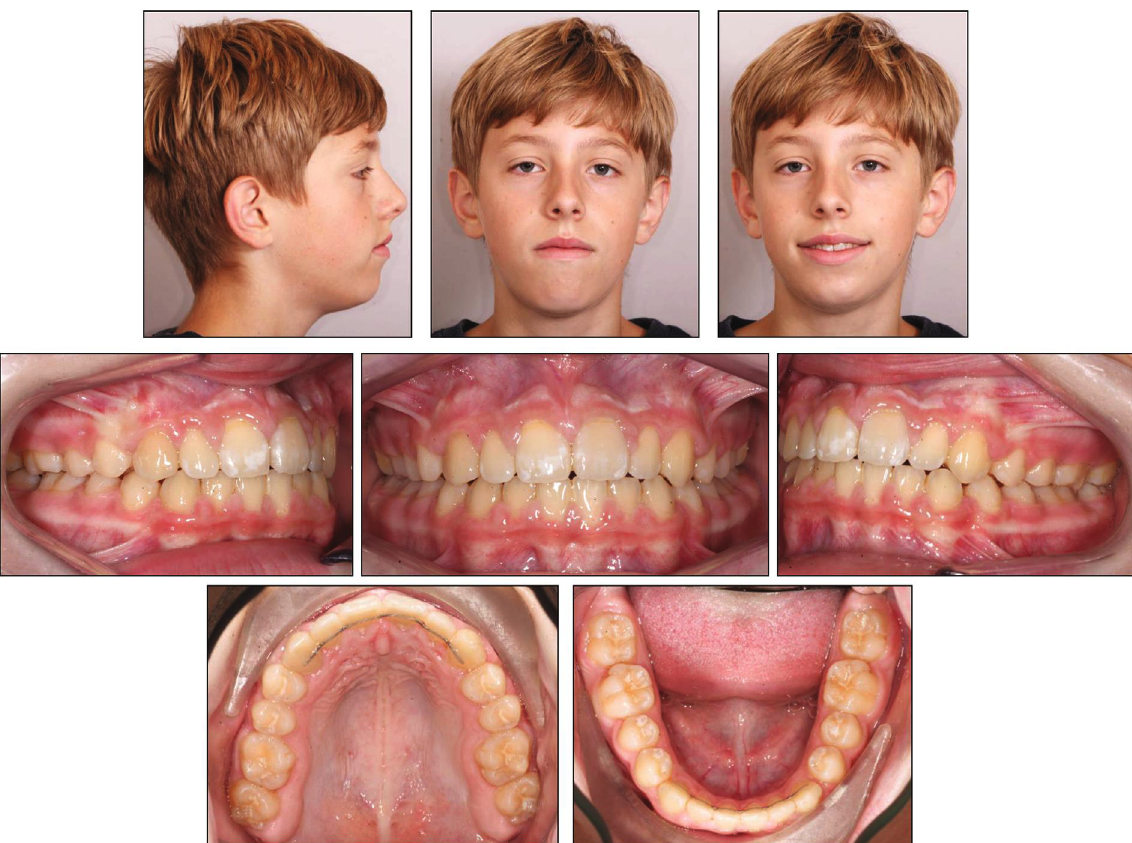
Figure 12: The patient ’ s facial and intraoral photographs taken after treatment at the age of 13 years and ten months.